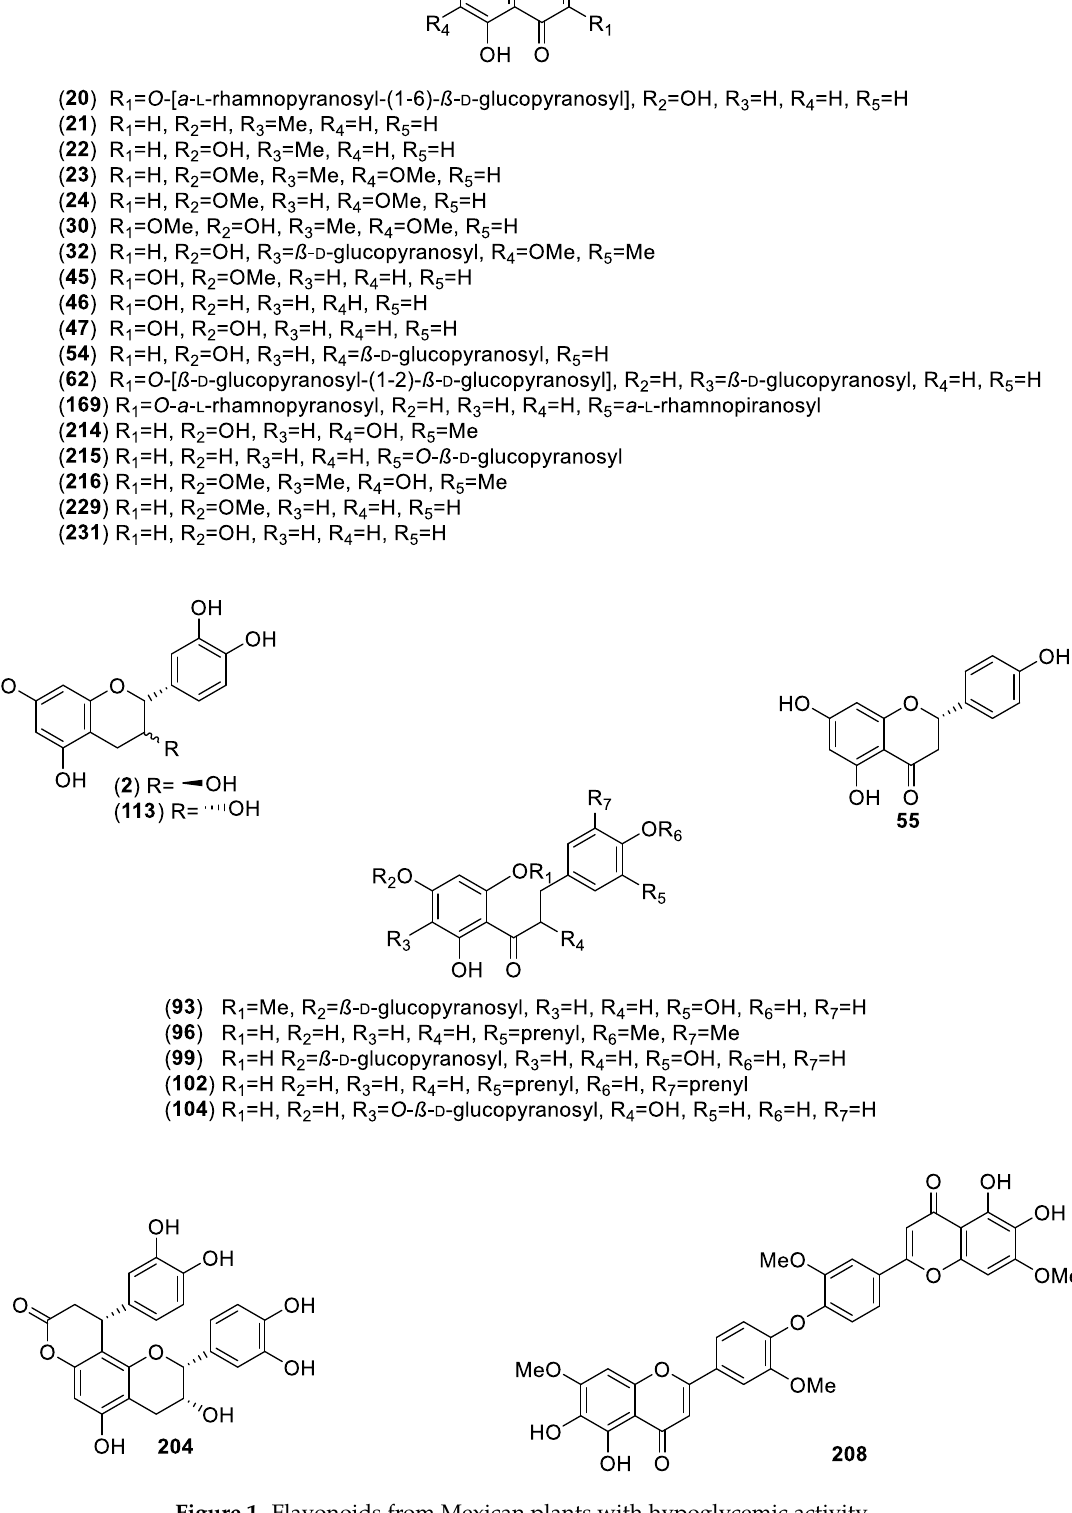
Figure 1. Flavonoids from Mexican plants with hypoglycemic activity.